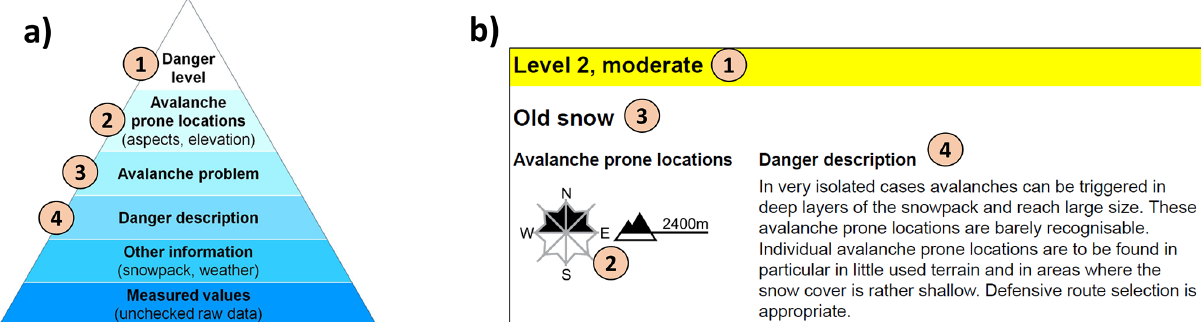
Figure 1. (a) In Europe, avalanche forecasts are structured according to an information pyramid (EAWS, 2021c), with the danger level at the top (1), followed by the avalanche-prone locations and the avalanche problem (2 and 3) and a danger description (4) providing further details. (b) Exemplary description of a danger region in the Swiss avalanche forecast (forecast published on 26 February 2021 at 08:00CET). Even though the danger description is written in present tense, it describes the expected conditions for the 24h following publication. Table 1. Overview showing examples of how information regarding contributing factors of avalanche danger is presented in avalanche fore- cast products. For each forecasting center, a randomly selected forecast product is provided in the supplementary material (see Supplement). Forecast in Factors Communication (Further) text elements in forecast through Likelihood, avalanche size a Graphic, keyword Avalanche problem description, travel and ter- rain advice, forecast details Likelihood, avalanche size a Graphic, keyword Summary, forecast discussion Keyword